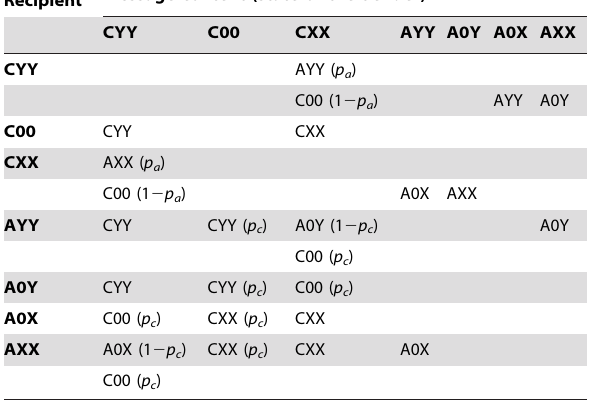
Table 1. Matrix of states of agents resulting from a single message sent by the ‘Sender’ and received by the ‘Recipient’ in given